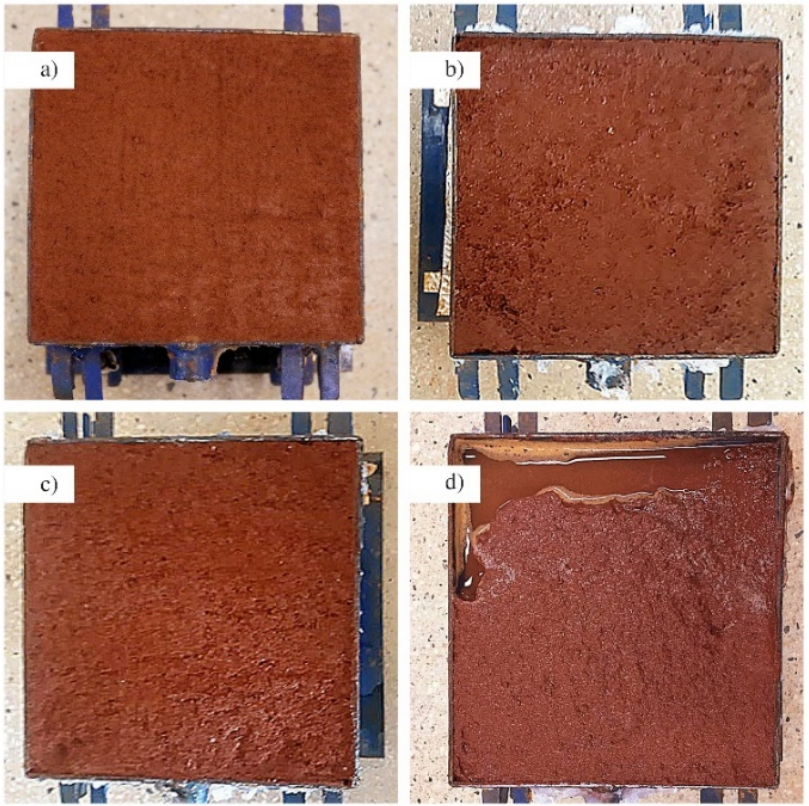
Figure 5. Specimen surface condition after flume tests for various void ratios and hydraulic shear stresses: ( a ) test #5, at e = 1.0 and τ h = 1.93 Pa; ( b ) test #6, at e = 1.0 and τ h = 1.93 Pa; ( c ) test #7, at e = 1.5 and τ h = 0.82 Pa; and ( d ) test #8, at e = 1.5 and τ h = 0.82